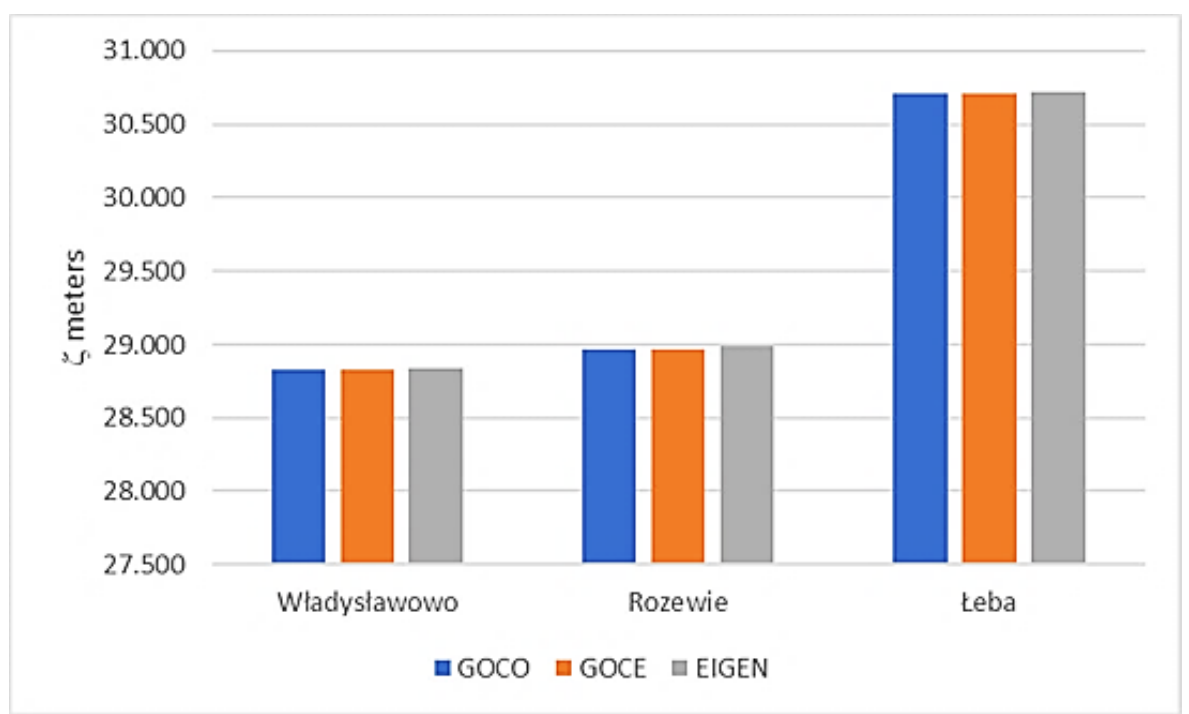
Figure 11. Height anomalies calculated from different geopotential models at tide gauge stations in Władysławowo Rozewie and Ustka.